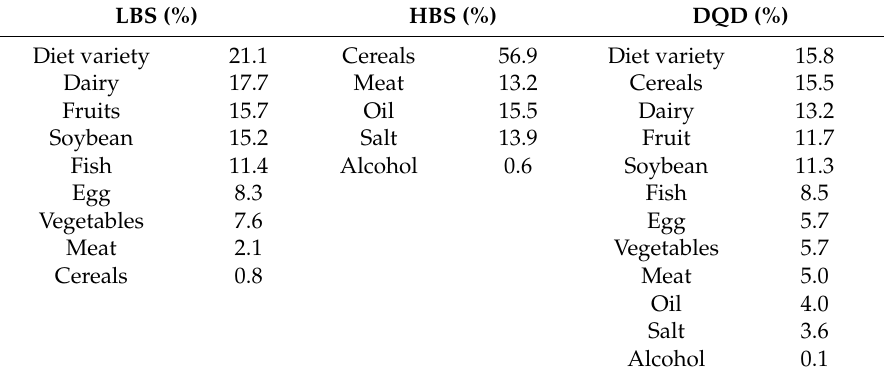
Table 4. Contribution rates of DBI-07 components to LBS, HBS and DQD.